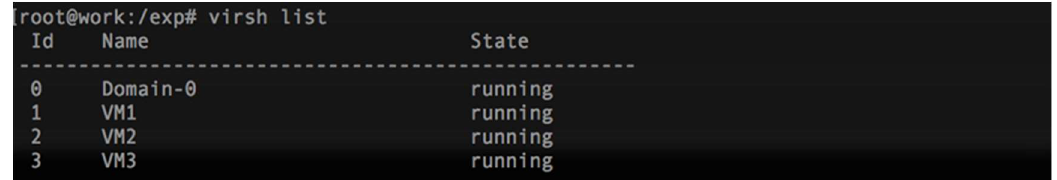
Table 5. Security settings of VM1, VM2, and VM3. Figure 4. Command listing all running virtual machines. Figure 4. Command listing all running virtual machines.